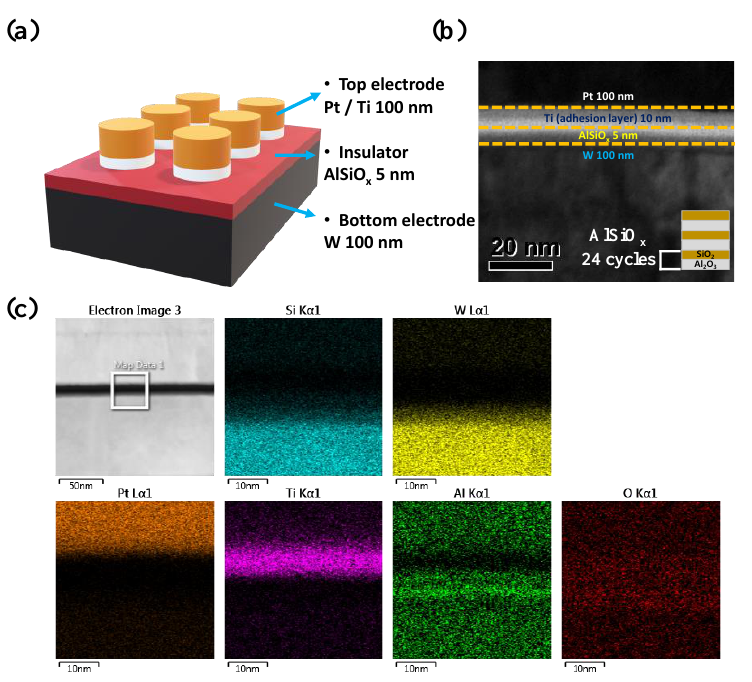
Figure 1. ( a ) Schematics image of Pt/Ti/AlSiO x /W device, ( b ) cross-sectional TEM image, ( c ) EDS mapping images of Si, W, Pt, Ti, Al, and O elements collected from the area indicated in the TEM image of the Pt/Ti/AlSiO x /W device.